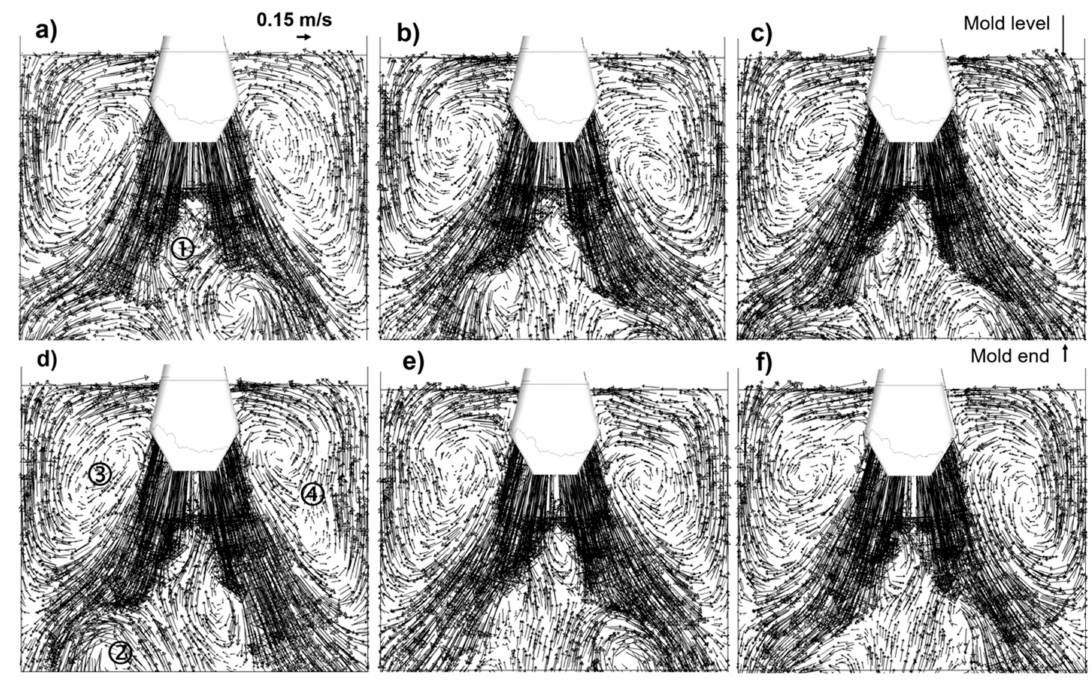
Figure 5. Velocity vectors at the central symmetrical plane of the mold at di ff erent times, ( a ) 120, ( b ) 130, ( c ) 140, ( d ) 150, ( e ) 160 and ( f ) 170